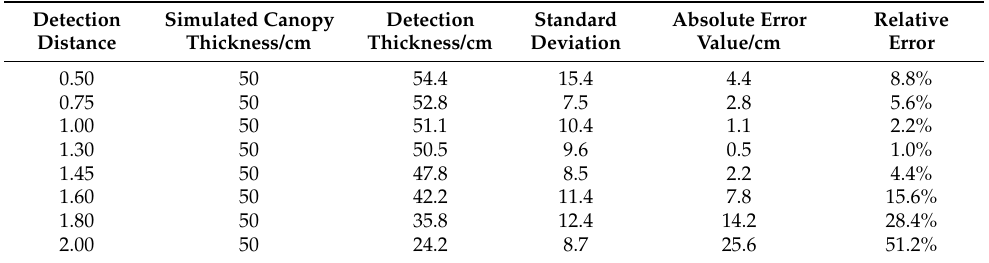
Table 2. Results of simulated canopy thickness detection experiment at different detection distances.